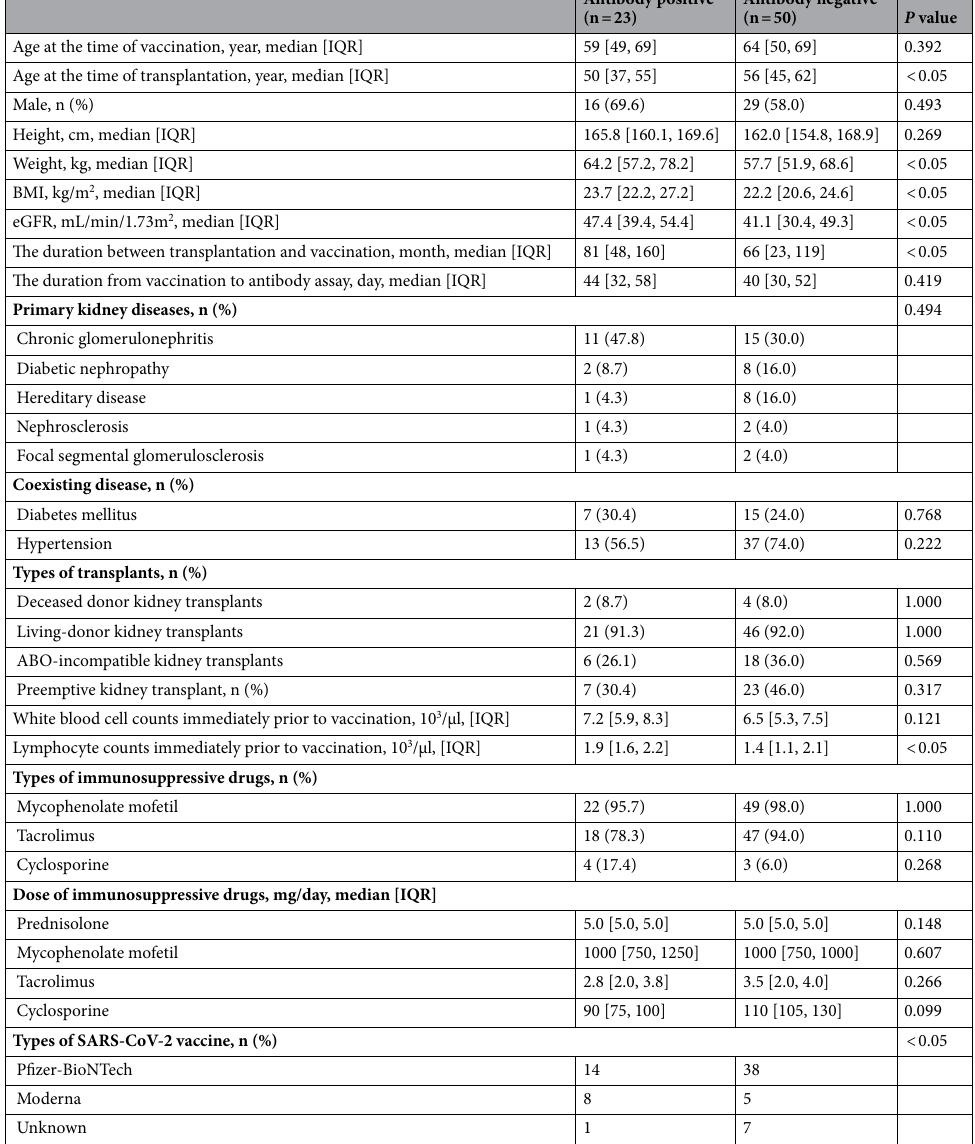
Table 2. Comparison between antibody-acquired and non-acquired groups. IQR , interquartile range; BMI , body mass index; eGFR , estimated glomerular filtration